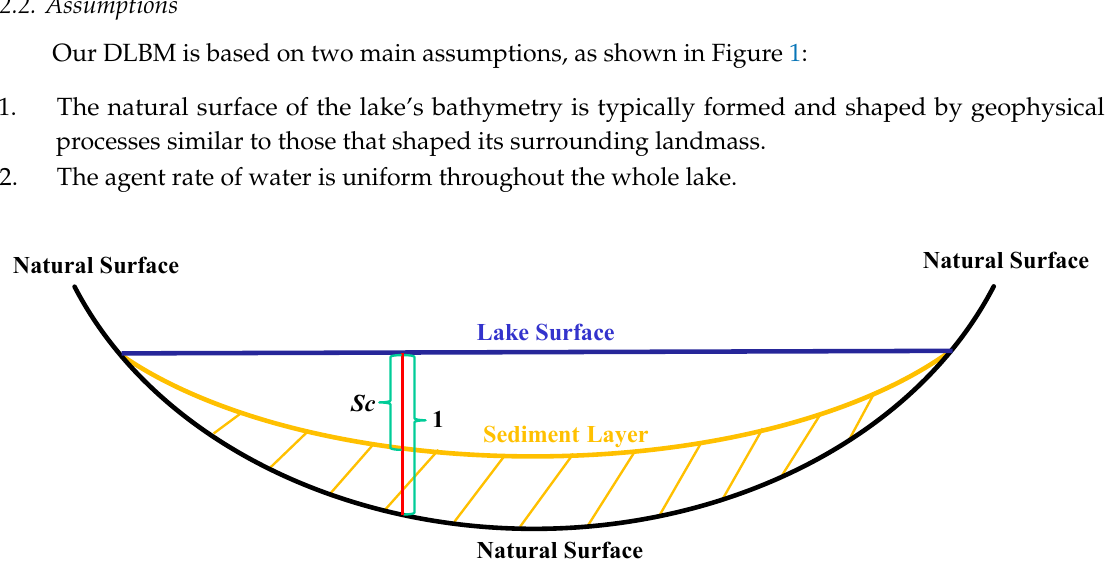
Figure 1. The deposition cross-section of the lake profile. The blue line represents the lake water surface, the black line represents the natural bottom of the lake, and the yellow area represents the sediment layer. The Sc is a scale value, equal to the water depth divided by the distance between the lake’s water surface and the natural bottom. The Sc becomes 1 when there is no sediment.